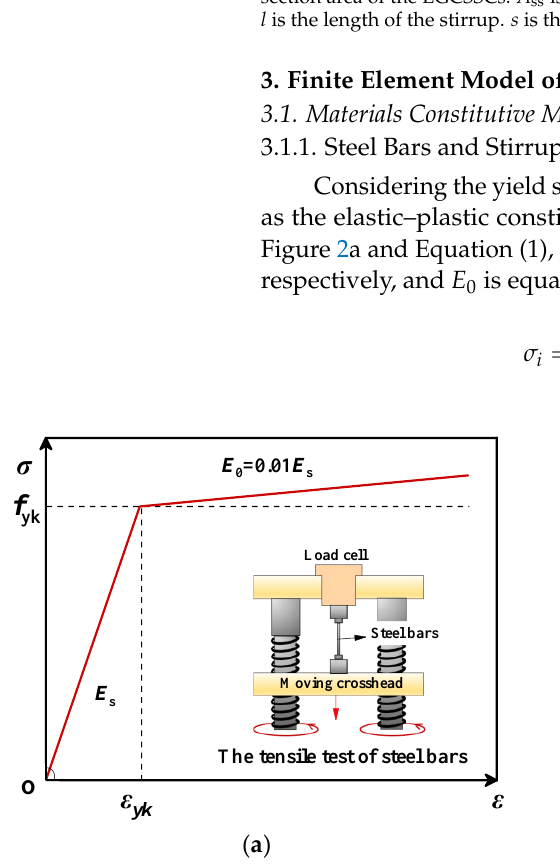
Figure 2. Constitutive models for materials: ( a ) steel bars and stirrups; ( b ) concrete.